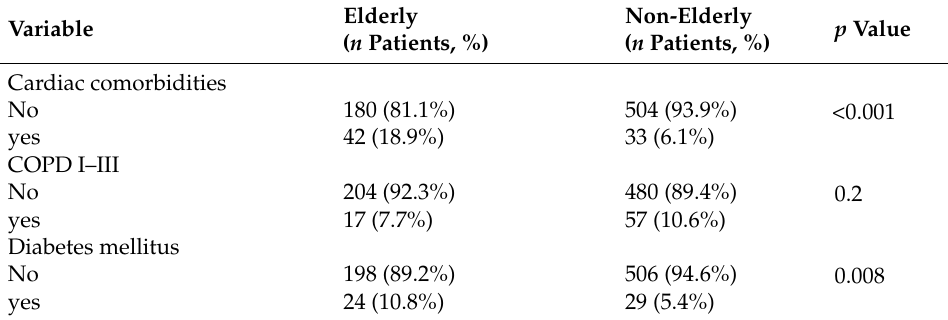
Table 1. Comorbidities in the study population.